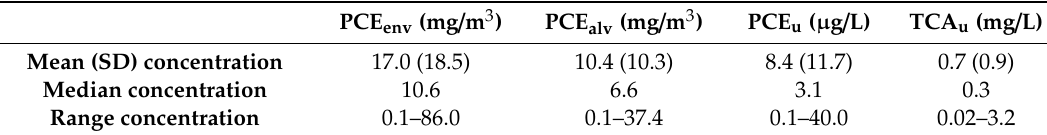
Table 1. Results of the evaluation of occupational perchloroethylene (PCE) exposure in the whole sample of dry-cleaning operators. (PCE env : PCE environmental concentrations, PCE alv : PCE in exhaled alveolar air, and PCE and trichloroacetic acid (TCA) in urine samples collected at the end of the work shift (PCE u and TCA u respectively).